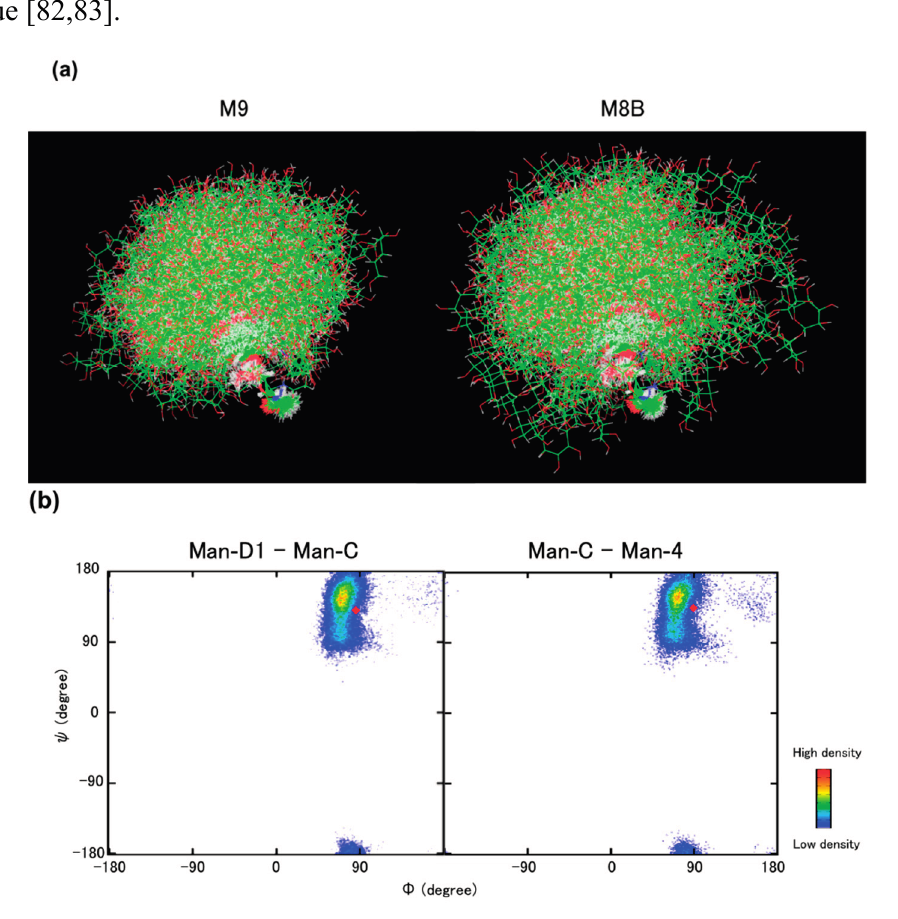
Figure 6. ( a ) Superimposition of 240 conformers extracted from the replica exchange MD simulation results of the M9 and M8B oligosaccharides [84]; ( b ) Density maps of glycosidic linkage torsion angles of the α 1,2-linked trimannosyl moiety at the D1 branch of the M9 oligosaccharide obtained using NMR-validated replica exchange MD simulations. Red circles indicate the conformations of the Man- α 1,2-Man glycosidic linkages of the sugar chain in complex with VIP36 CRD , ( Φ , ψ ) = (89°, 132°) and (92°, 134°) corresponding to the Man-D1–Man-C and Man-C–Man-4 linkages, respectively, on the basis of crystallographic data (PDB codes: 2DUR and 2E6V, respectively) [27]. The torsion angles Φ and ψ are defined as O 5 -C 1 -O 1 -C' 2 and C 1 -O 1 -C' 2 -C' 3 , respectively. Figure 6a was adapted from Yamaguchi et al . [84] with the permission of John Wiley and